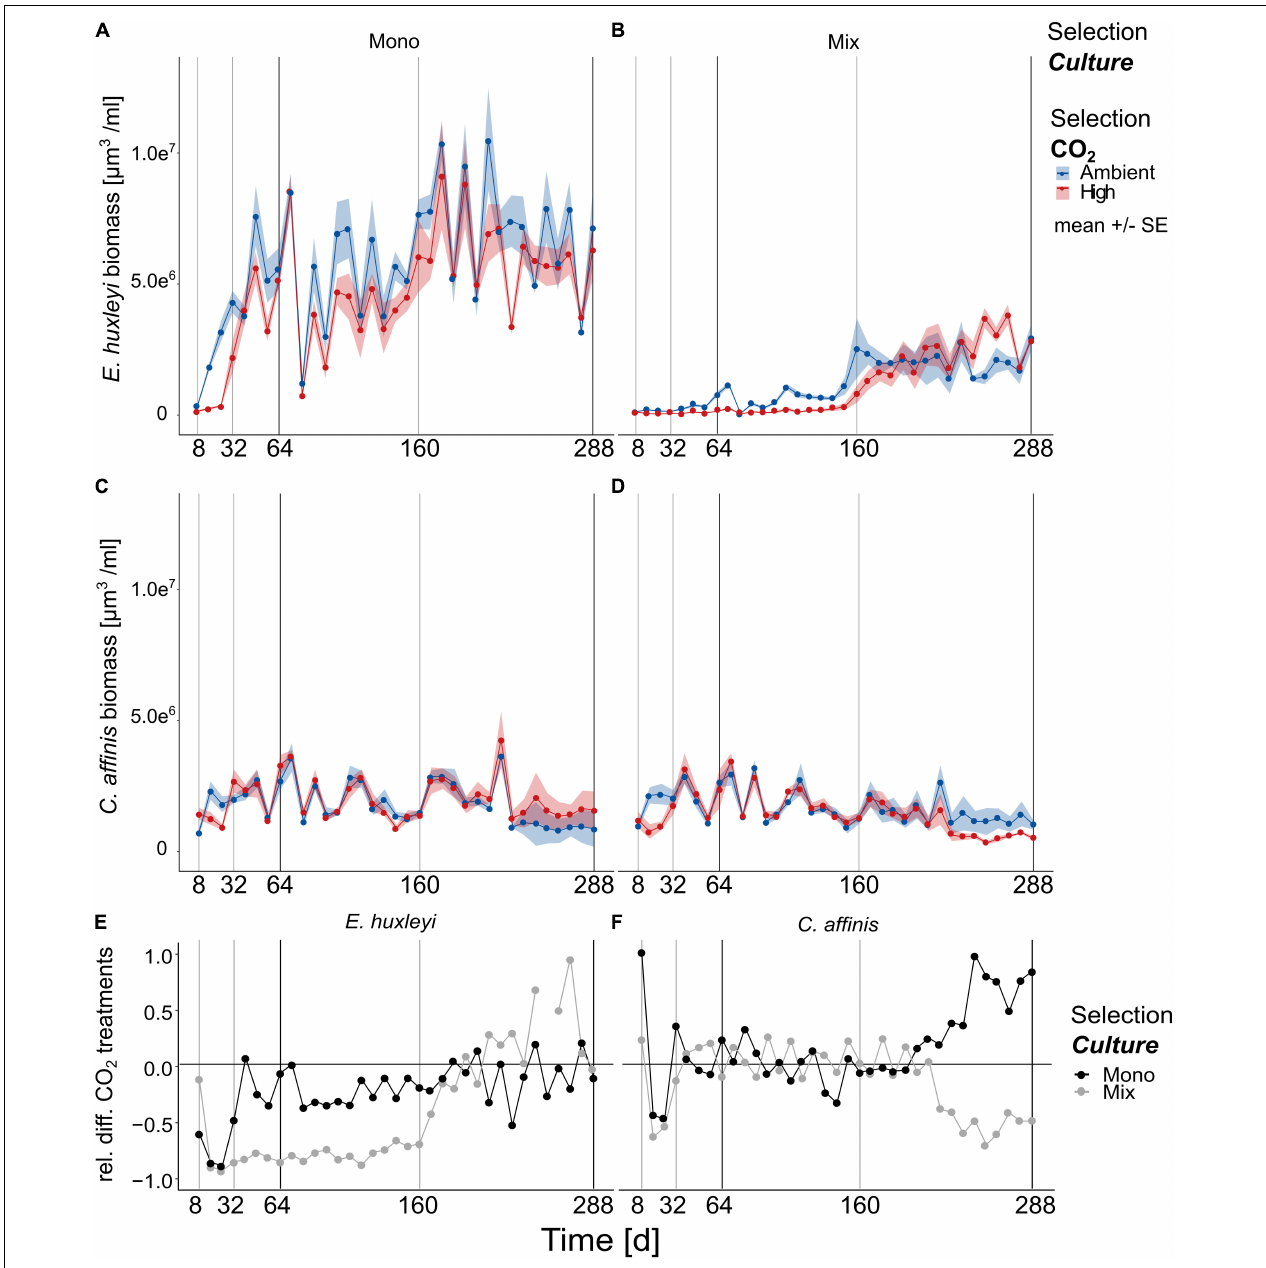
FIGURE 3 | Biovolume changes over approx. 200 generations. The biovolume of E. huxleyi (A,B) and C. affinis (C,D) measured at the end of each batch cycle over 36 batch cycles in the four selection treatments is shown here [mean ± SE; n = 5 (5 replicates/treatment) for days 1–200; and n = 4 (4 replicates/treatment) for days 200–288 per time point]. The light gray and black lines show the time points where samples were taken for genotype reisolation. The black lines show when the cultures were additionally tested for adaptation in the reciprocal assay test. Panels (E,F) show the relative difference between the ambient and high CO 2 treatments for E. huxleyi (E) and C. affinis (F) when grown alone (black points) and with the respective other species (gray points) for better understanding how the responses to increased CO 2 concentrations changed over